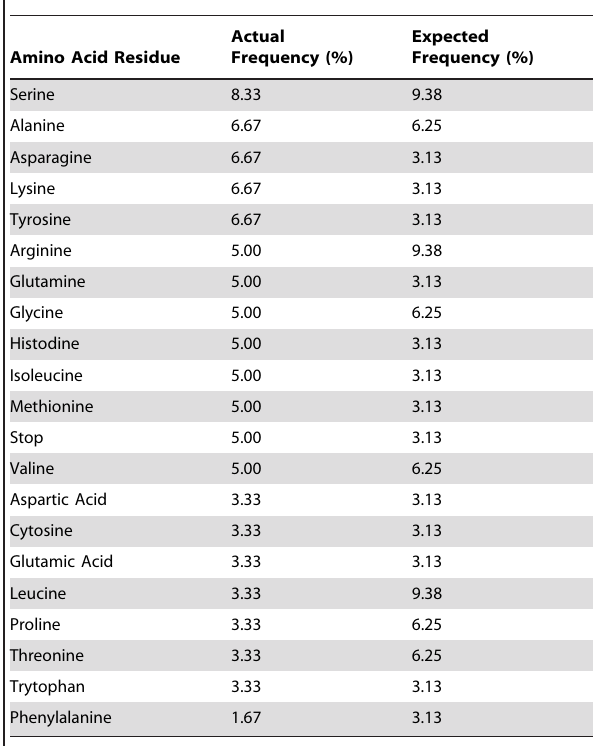
Table 5. Actual and expected frequencies of hinge amino acids from randomly selected representatives of the hinge mutant